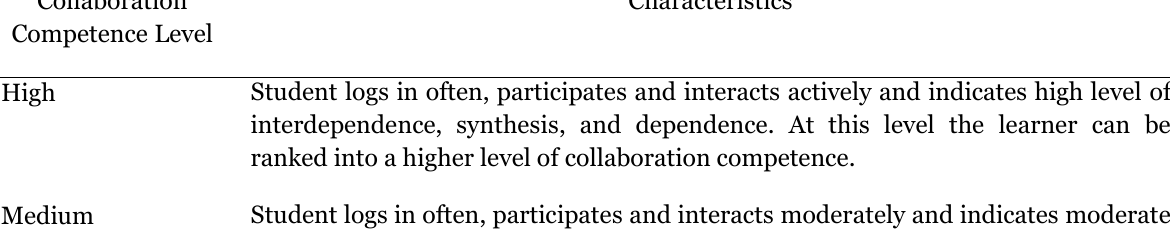
Characteristics Associated with Collaboration Competence Levels Collaboration Competence Level